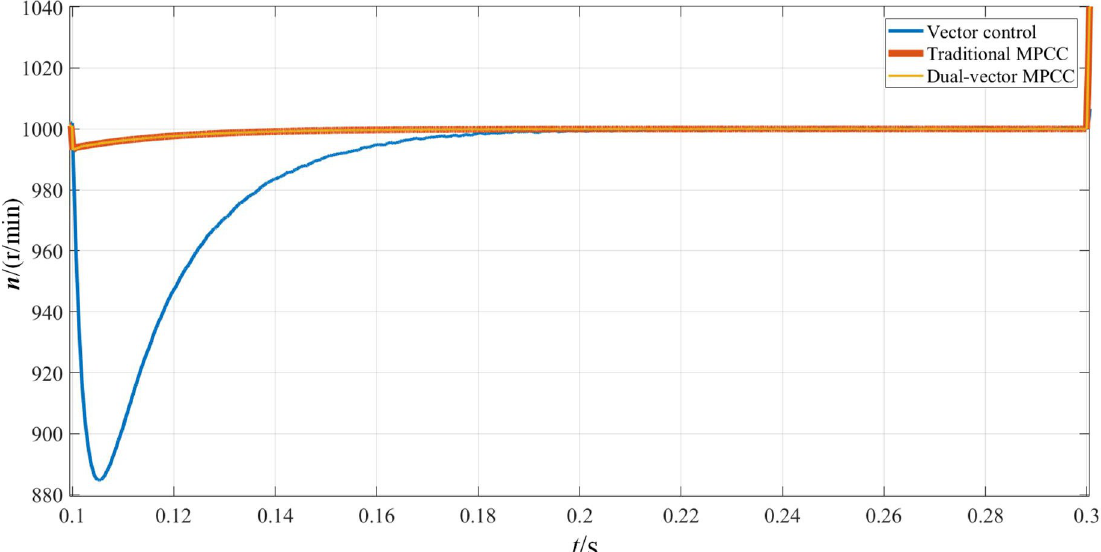
Fig 10. Rotational speed waveform when the motor is loaded with torque.